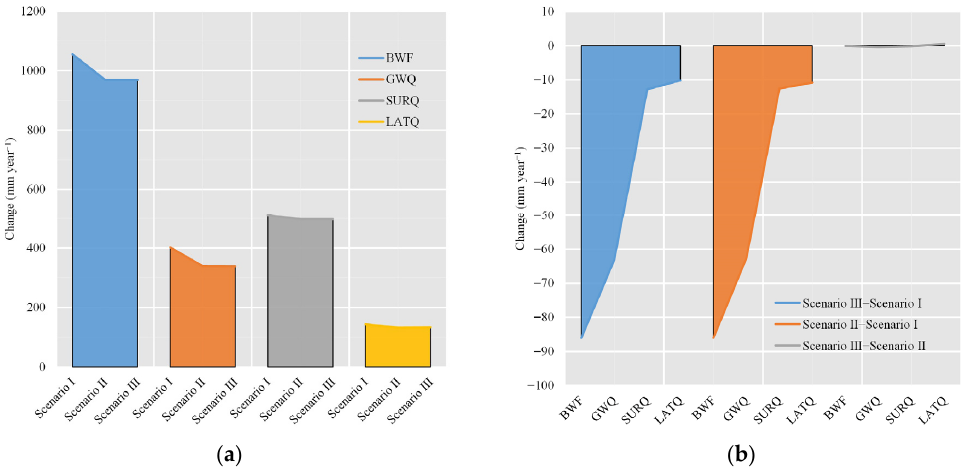
Figure 4. Simulation of the average annual values of blue water flow (BWF) and its components (surface runoff (SURQ), lateral flow (LATQ), groundwater flow (GWQ)) ( a ) in the upper Ganjiang River basin due to climate change, land-use change, and the combined effects of all the above factors ( b ).